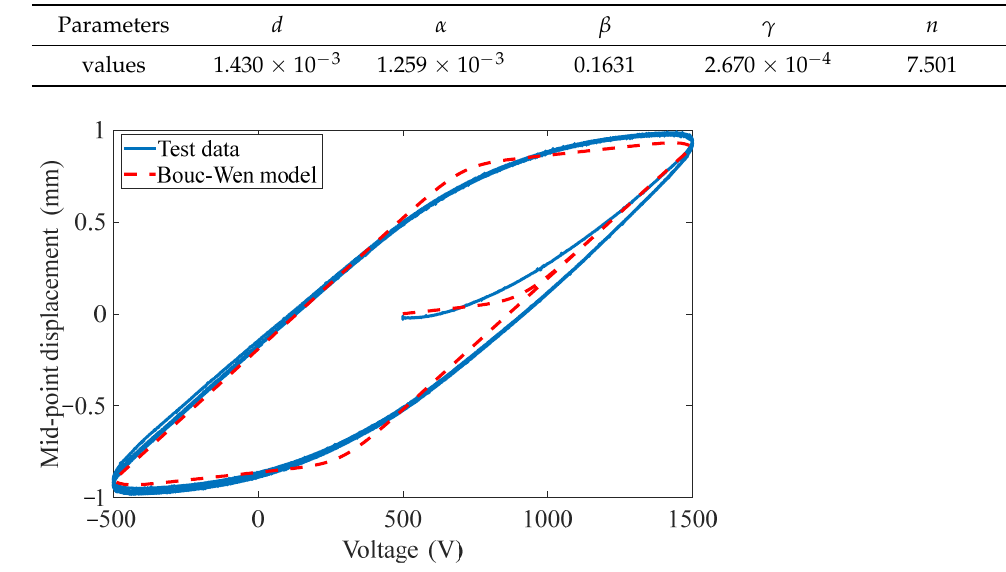
Table 1. Optimized parameters of Bouc–Wen model.